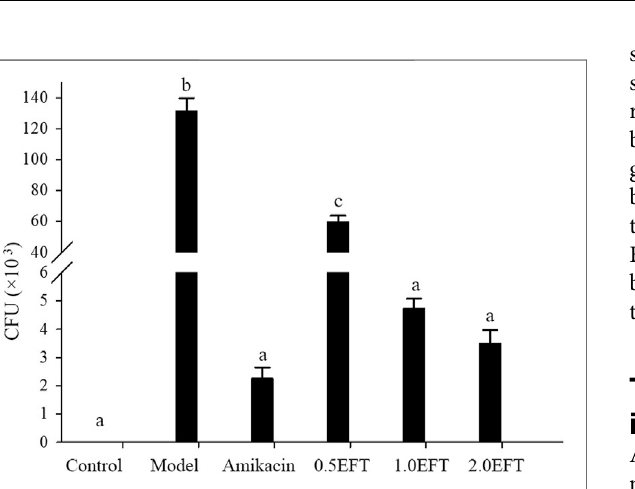
FIGURE 4 | The HE-stained change of lung histopathology. (A) The sham group with intact alveoli (green arrow), (B) the model group with massive in fl ammatory in fi ltrates (yellow arrow), (C) the amikacin group, (D) the EFT (0.5 g/kg) group, (E) the EFT (1.0 g/kg) group, and (F) the EFT (2.0 g/kg) group.